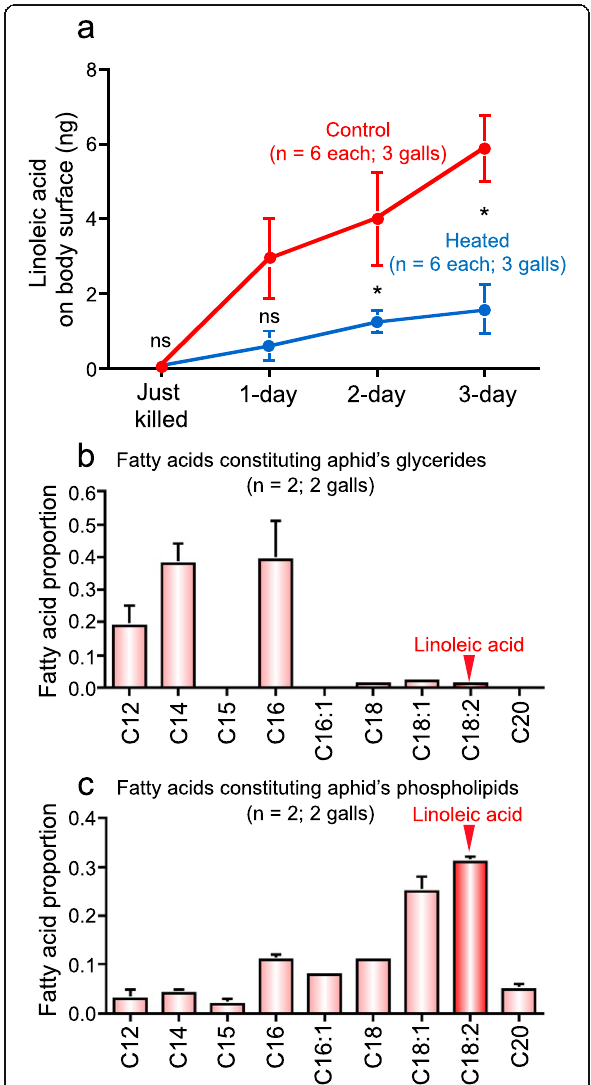
Fig. 8 Origin of linoleic acid on the body surface of T. styraci . ( a ) Relative quantities of linoleic acid on the body surface of dead old adults with or without heating by microwave after freeze-killing. Asterisks indicate statistically significant differences ( P < 0.05) as compared with the control group (Wilcoxon rank-sum tests: *, P < 0.05; ns, not significant). ( b ) Relative quantities of fatty acids released by hydrolysis of glycerides extracted from live old adults . ( c ) Relative quantities of fatty acids released by hydrolysis of phospholipids extracted from live old adults . Sample sizes are shown in parentheses and standard errors are shown by vertical